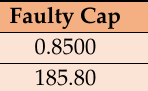
Table 2. The measured ESR and C.